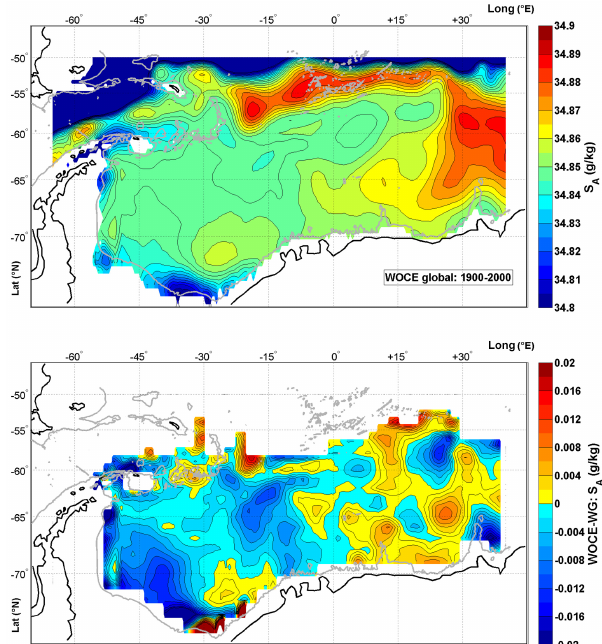
Figure 27. Absolute salinity (gkg − 1 ) at 800m from the global WOCE climatology during 2005 to 2012. (i.e. WOCE_global in Fig. 23). Panel (b) shows the difference with the entire time span of the data set provided, i.e. WOCE_global minus WG_all. The grey contour shows the 2000m isobath.